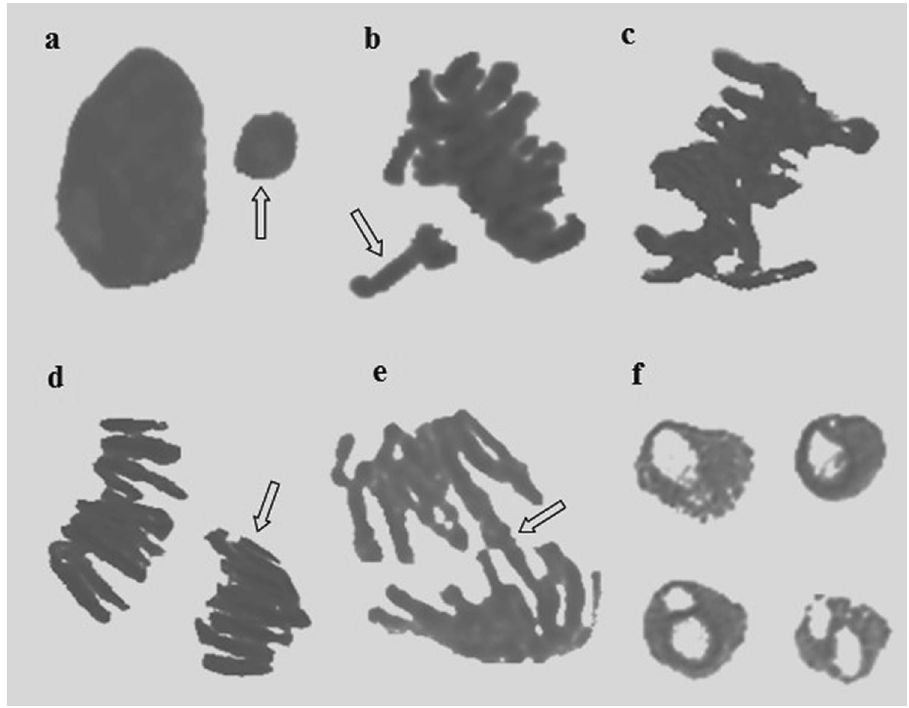
Figure 1. Chromosomal damage caused by diniconazole. ( a ) MN, ( b ) fragments, ( c ) sticky chromosome, ( d ) unequal distribution of chromatin, ( e ) bridge, ( f ) vacuole